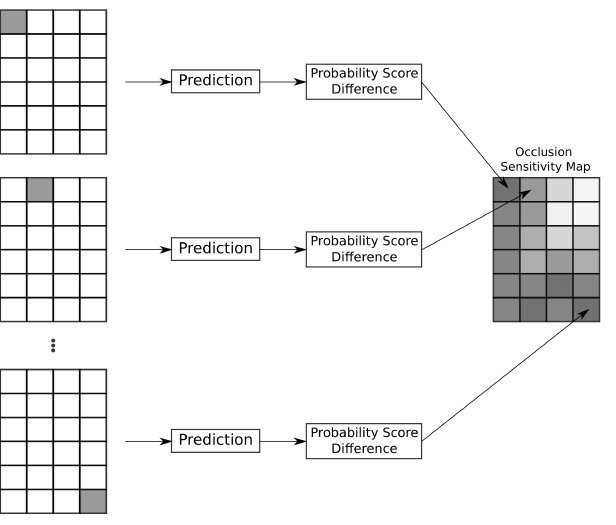
Figure 9. Proposed frequency range optimization algorithm based on occlusion sensitivity.